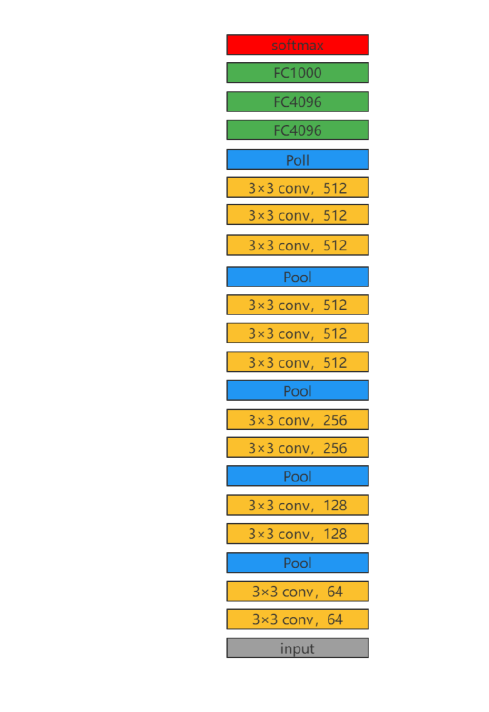
Figure 7. Convolution process of